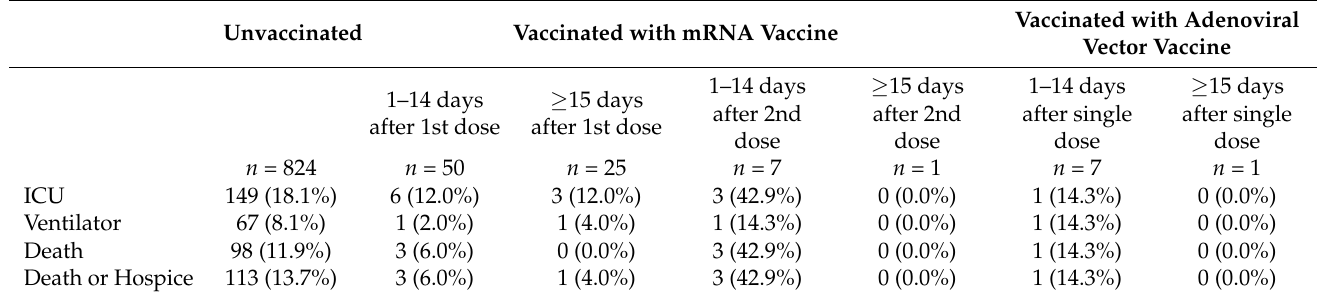
Table 2. COVID-19 outcomes of patients with or without prior